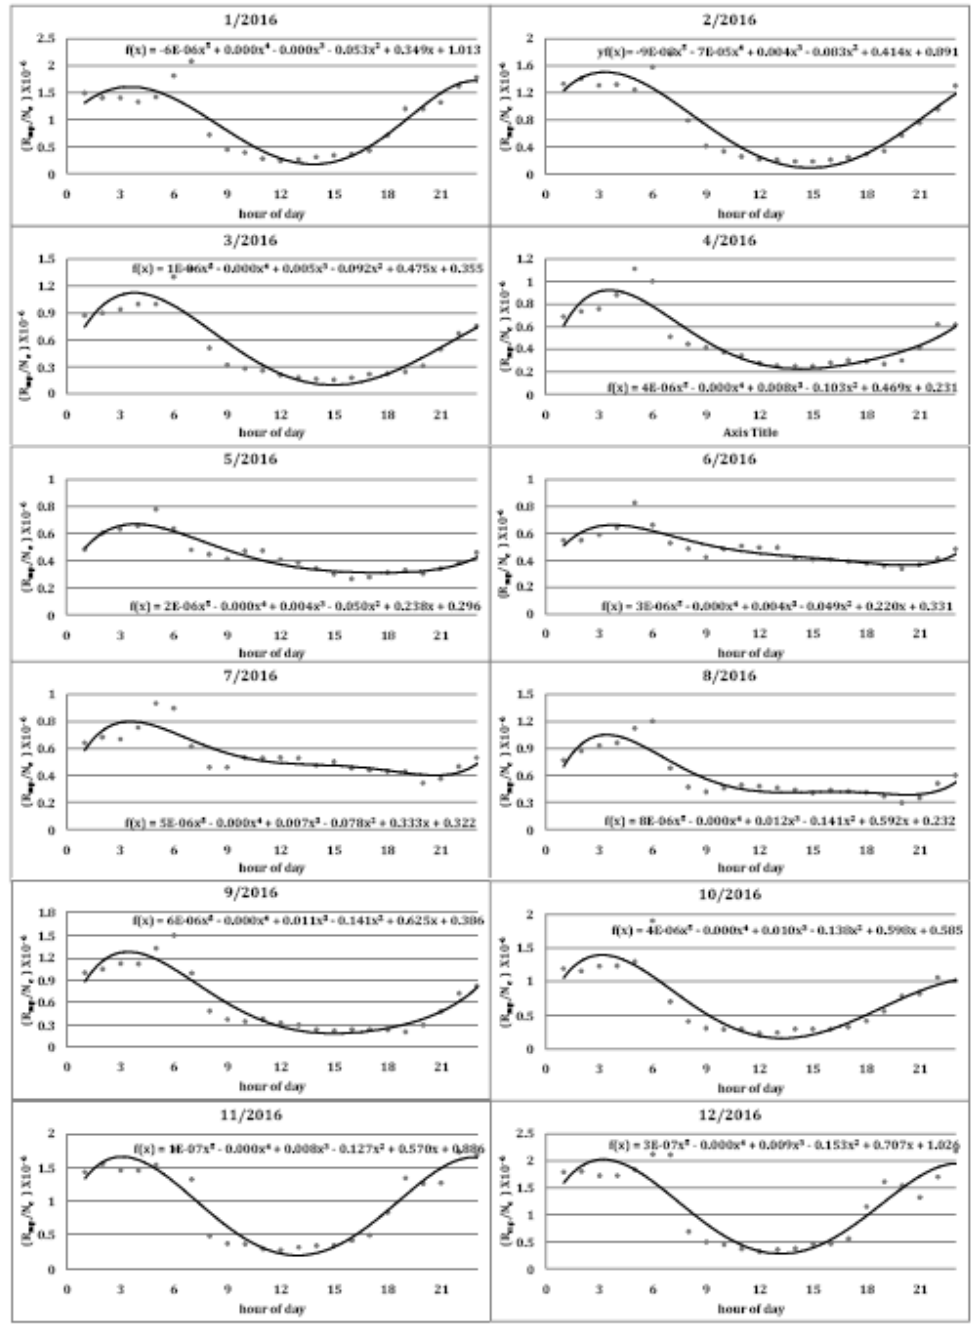
Fig. 9: Monthly median of (Rmp /Ne) for year